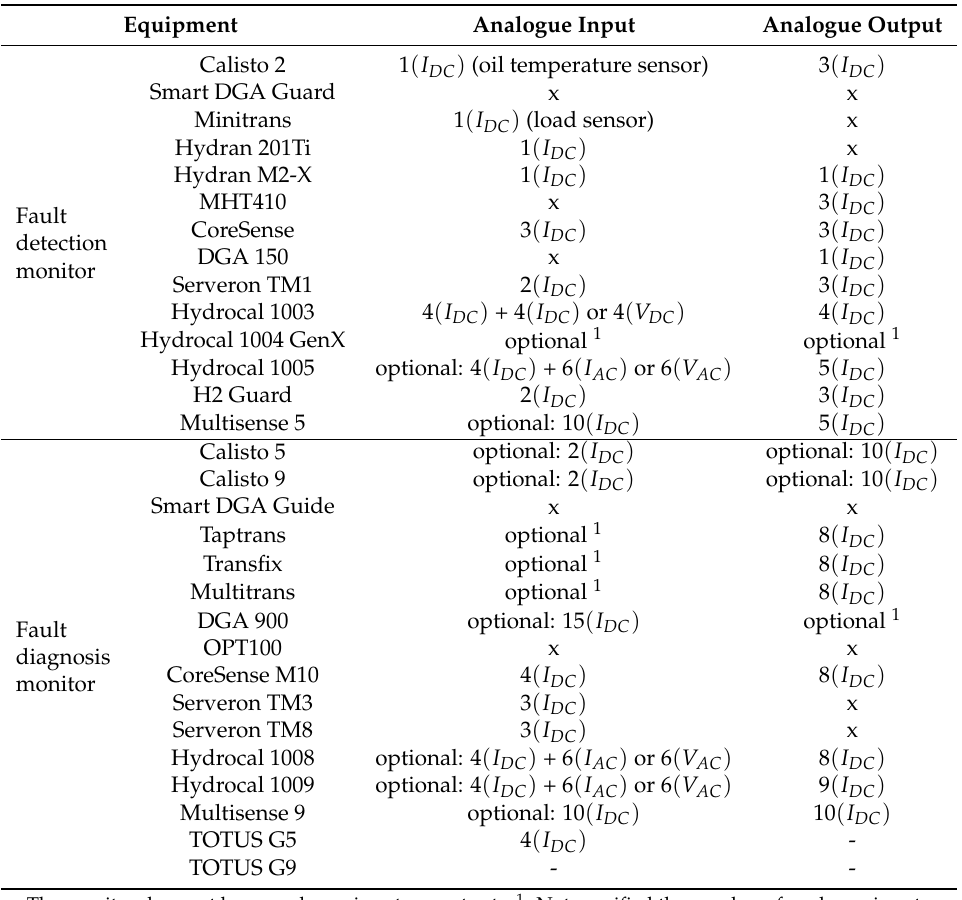
Table 12. Analogue inputs and outputs of gas-in-oil monitors (as indicated by the manufacturers).